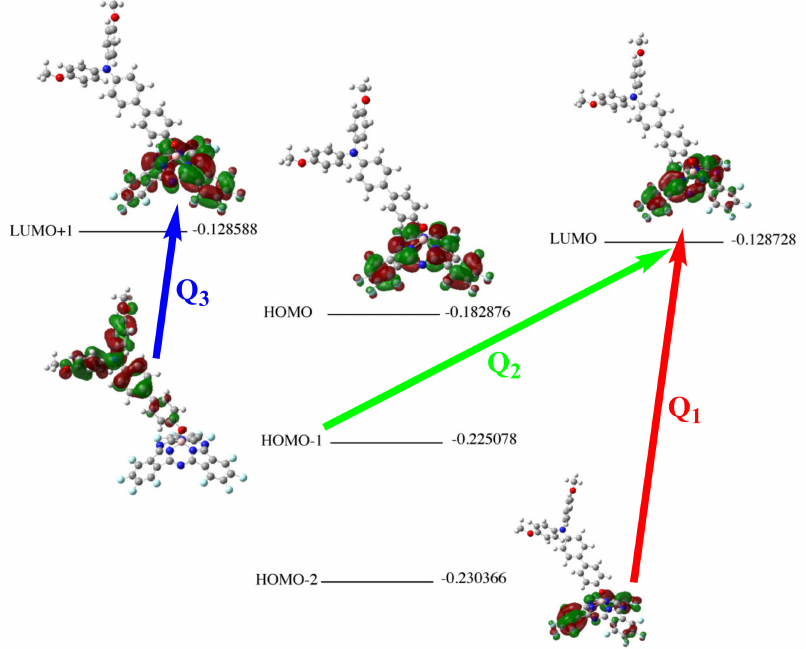
Figure 7. MO diagram showing, for SubPc(A3,F,F,H), the main transitions Q 1 , Q 2 and Q 3 contributing to the Q band. The Q 2 and Q 3 components are accompanied by a charge transfer phenomenon. Molecular orbital energies are in